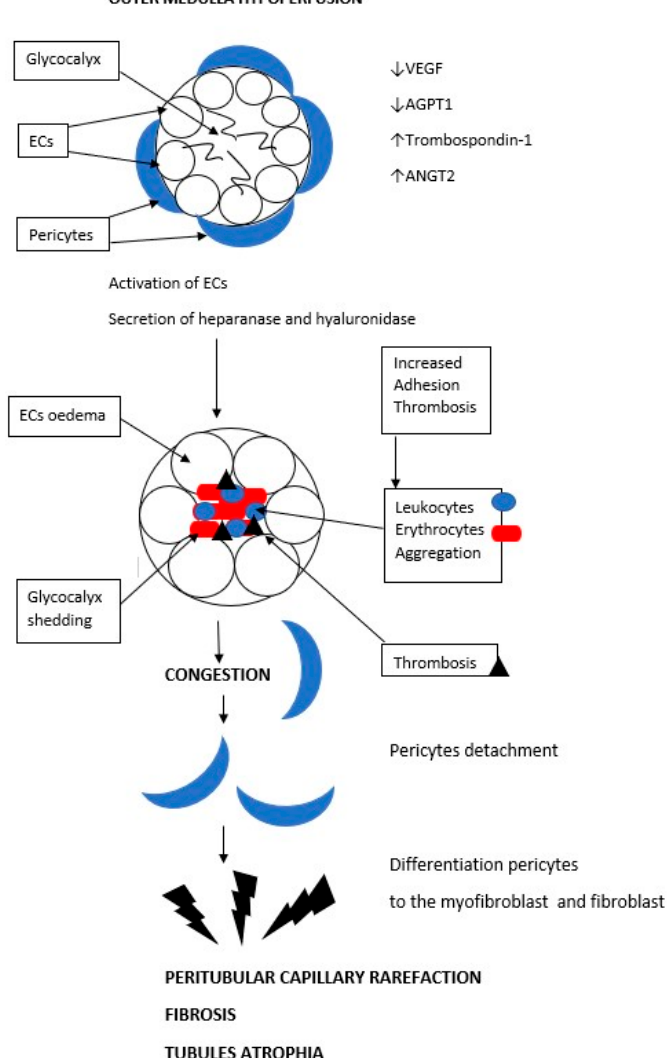
Figure 2. Mechanism of formation of peritubular capillary rarefaction. Consequence of acute ischemia and a cause of progression to chronic kidney disease.